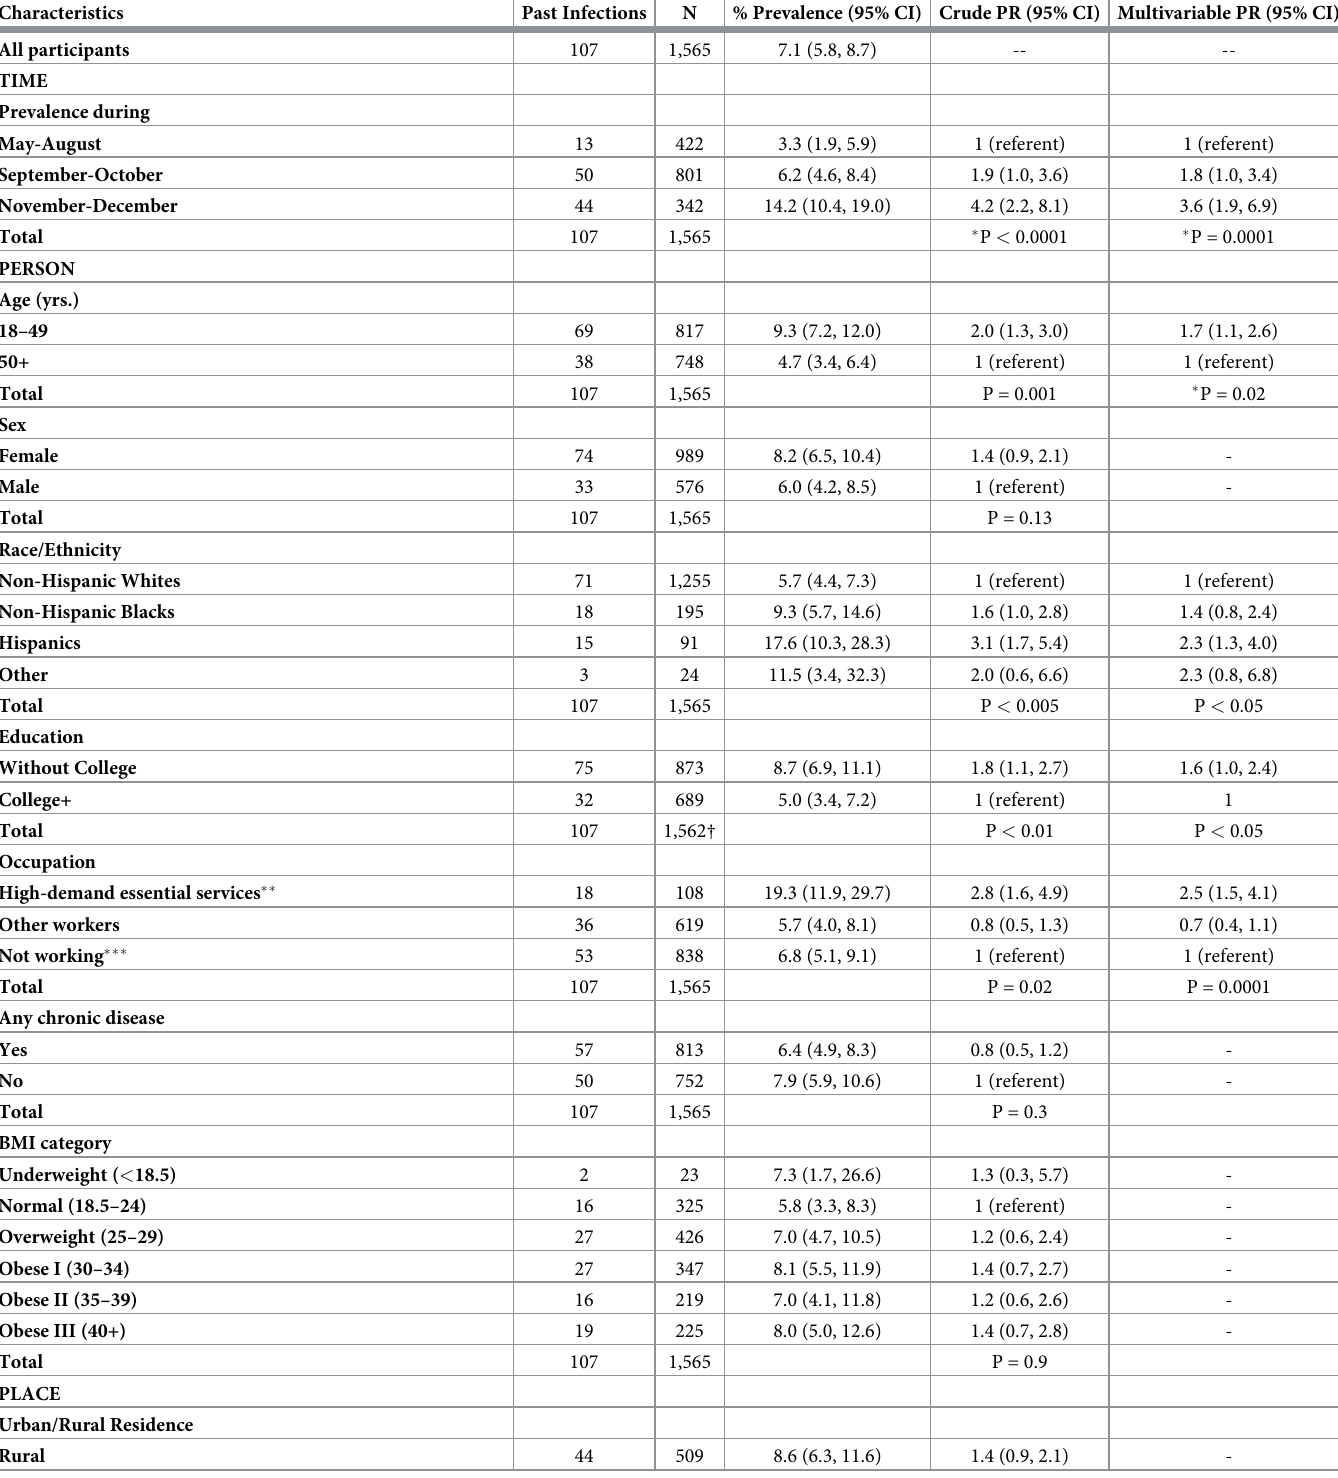
Table 1. Weighted period prevalence of SARS-CoV-2 past infection and prevalence ratios (PR) by select characteristics in a random sample of adults, Arkansas, May–December 2020.